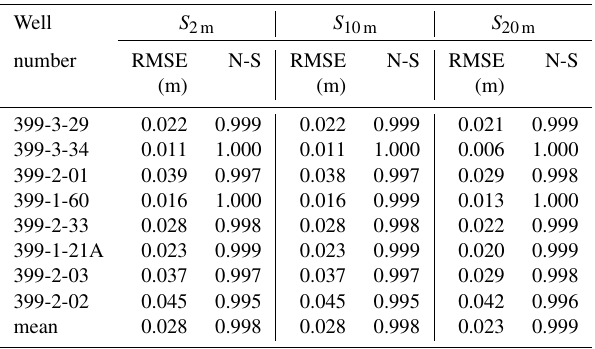
Table 3. The comparison between simulated and observed water table